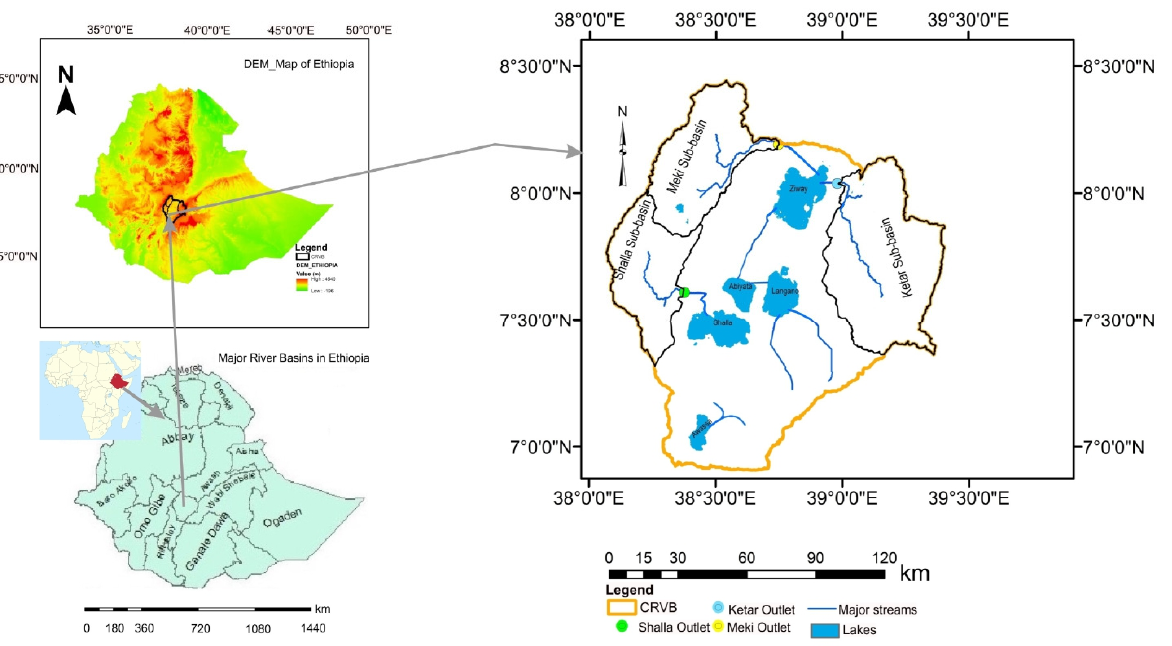
Figure 1. Location of Ethiopia in Africa, and the major river basins (bottom left); location of the study area within Ethiopia (top left), and the study sub-basins with their major stream outlets. The mean annual rainfall of the study area varies between 600 mm near the lakes and 1200 mm–1600 mm in the highlands. The average minimum temperature is 10.5 ◦ C, while the average maximum temperature is 24.3 ◦ C [16]. CRVB comprises four major